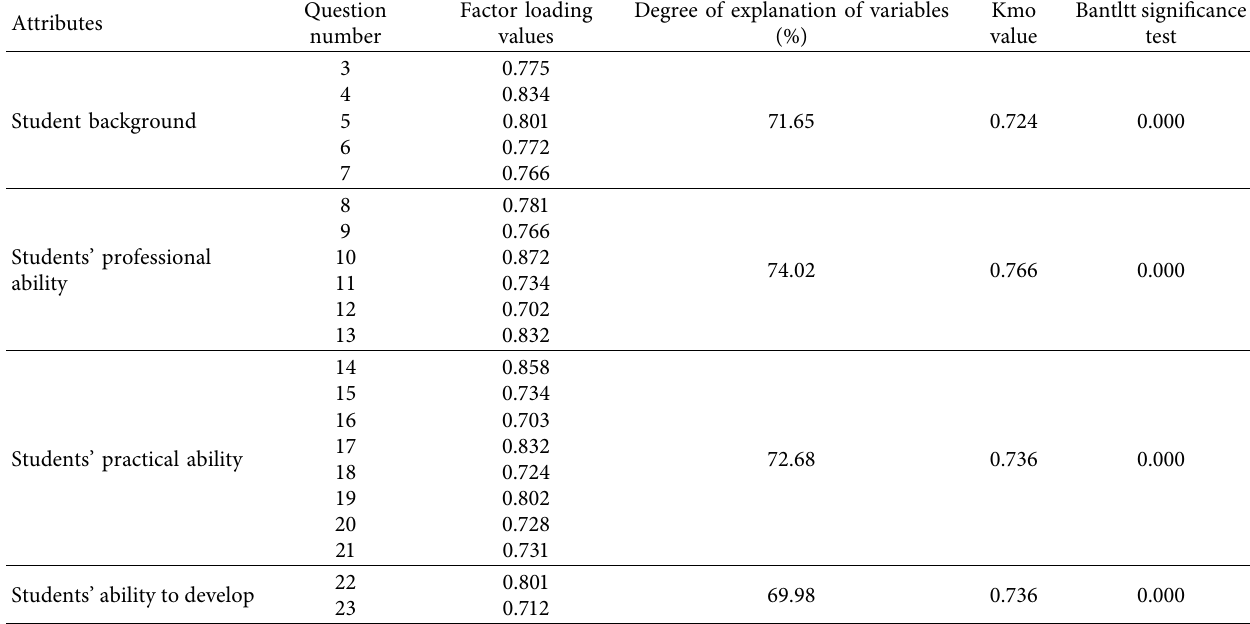
Table 3: Validity analysis of the graduate questionnaire.